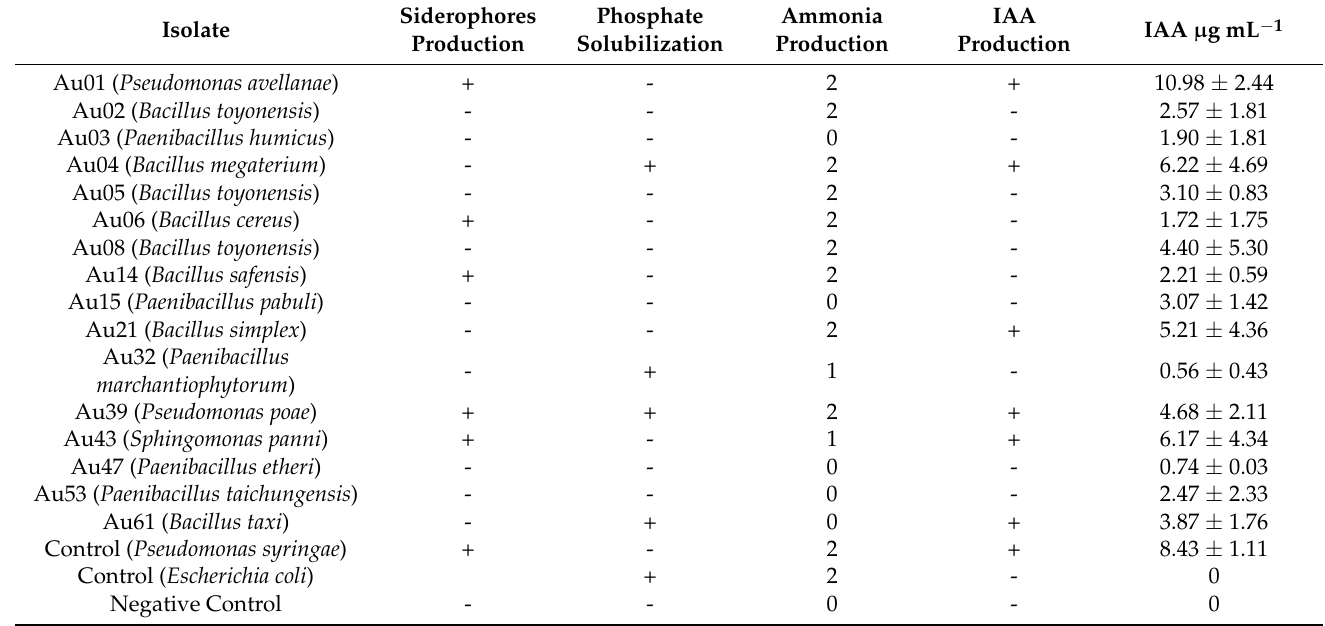
Table 2. The growth-promoting potential of the isolated endophytic bacteria based on siderophore, ammonia and IAA production and phosphate solubilization. + indicates the production of IAA, siderophores and phosphate solubilization. Ammonia production: 0—no production; 1—low production; 2—high production. IAA concentration values are the means ± standard deviation of three independent